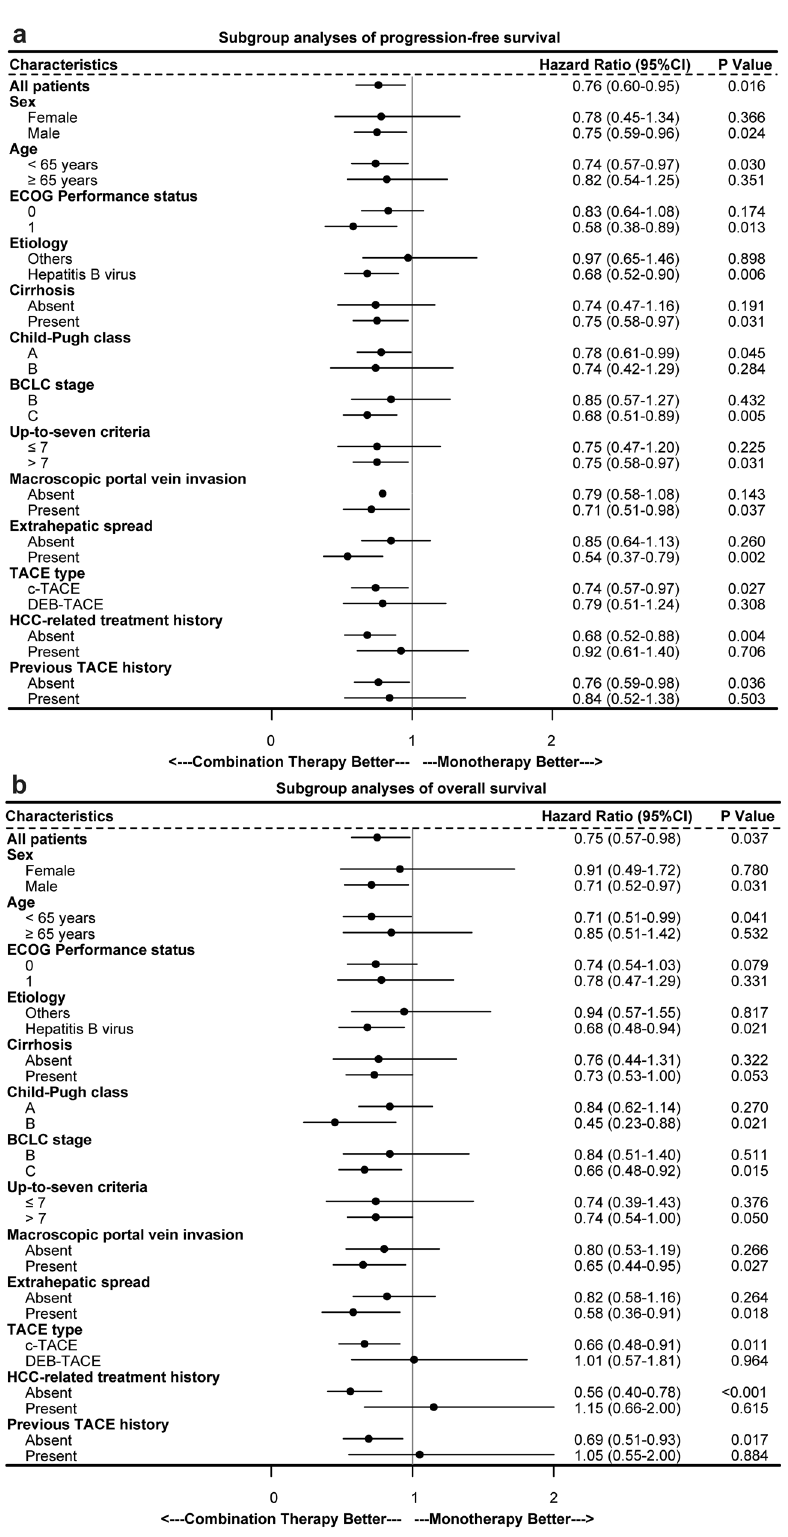
Fig. 3 Subgroup analysis of progression-free survival ( a ) and overall survival ( b ). HR hazard ratio, CI con fi dence interval, ECOG Eastern Cooperative Oncology Group, BCLC Barcelona Clinic Liver Cancer, TACE transarterial chemoembolization, cTACE conventional transarterial chemoembolization, DEB-TACE drug-eluting beads transarterial chemoembolization, HCC hepatocellular carcinoma